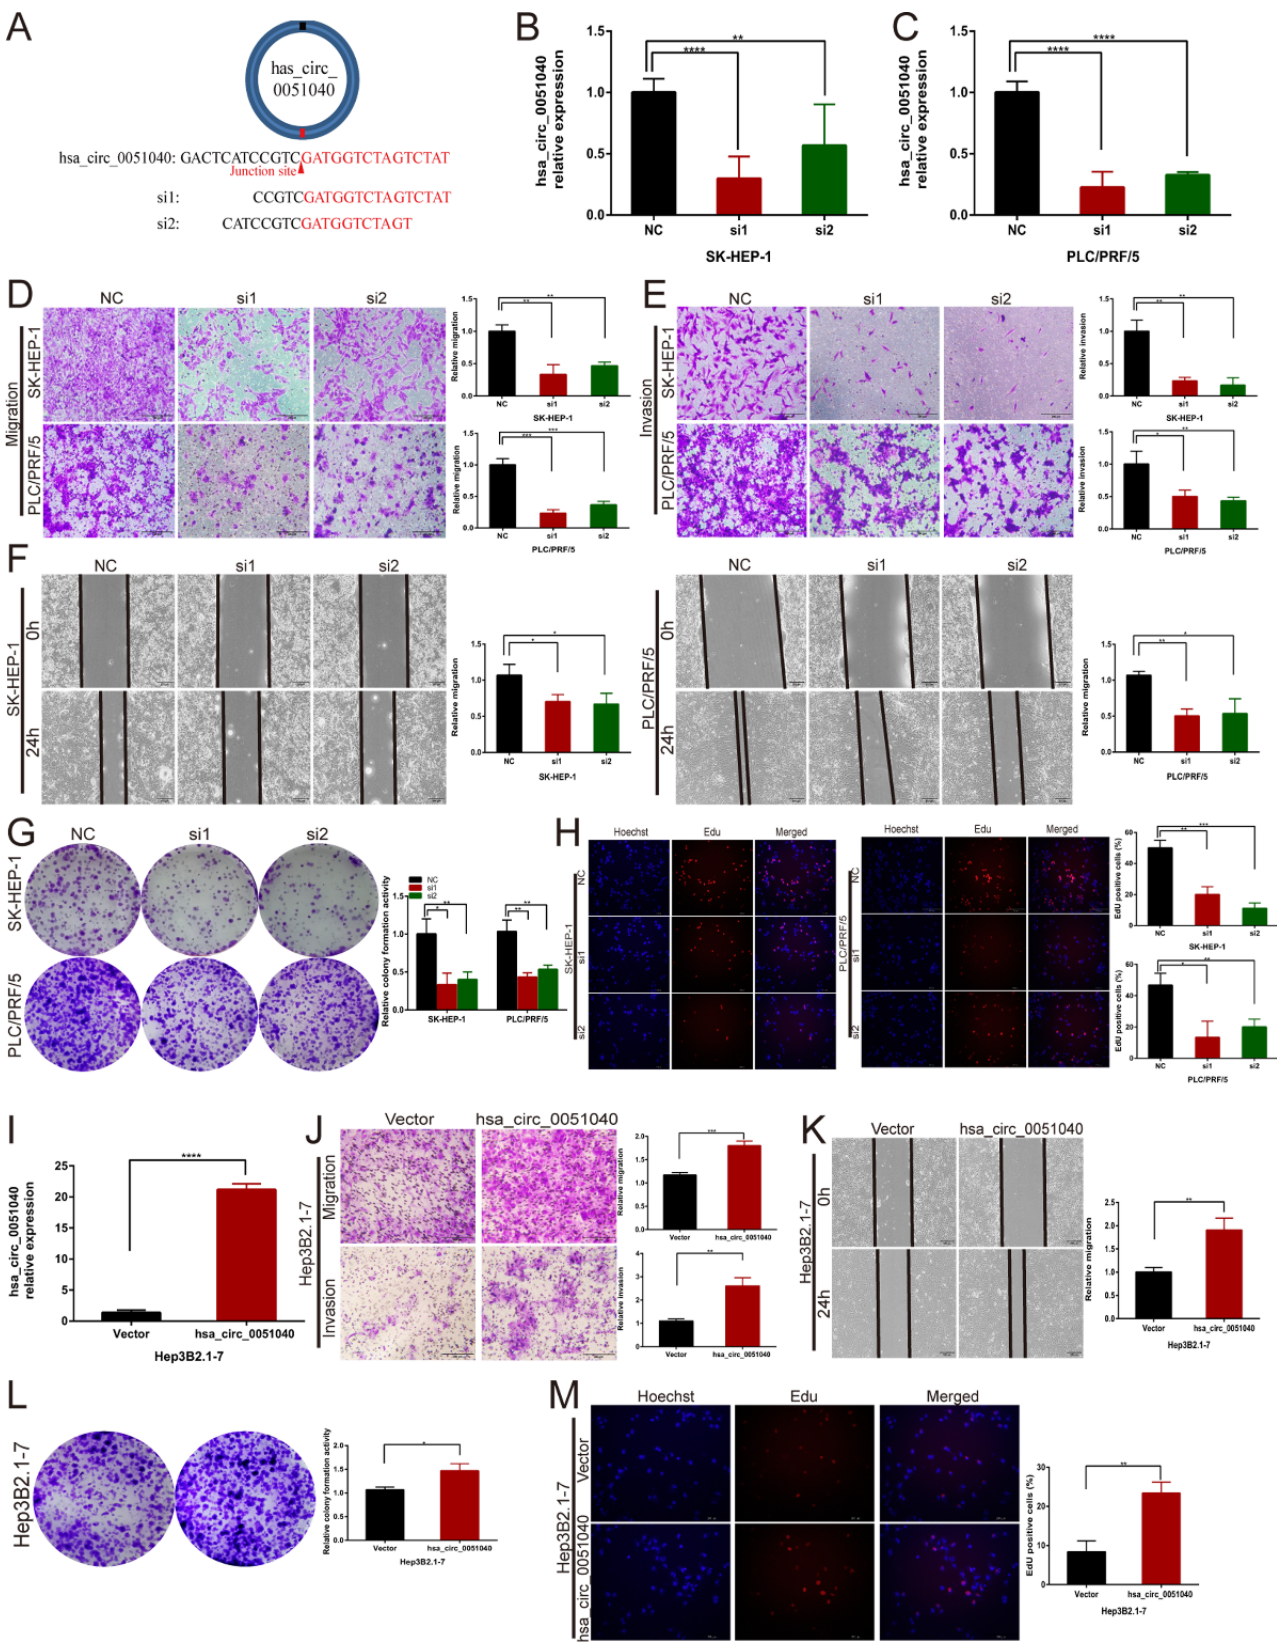
Figure 3. Hsa_circ_0051040 promotes the migration, invasion, proliferation and apoptosis of HCC cells in vitro. ( A ) Schematic illustration of two targeted siRNAs. siRNAs target the back splicing